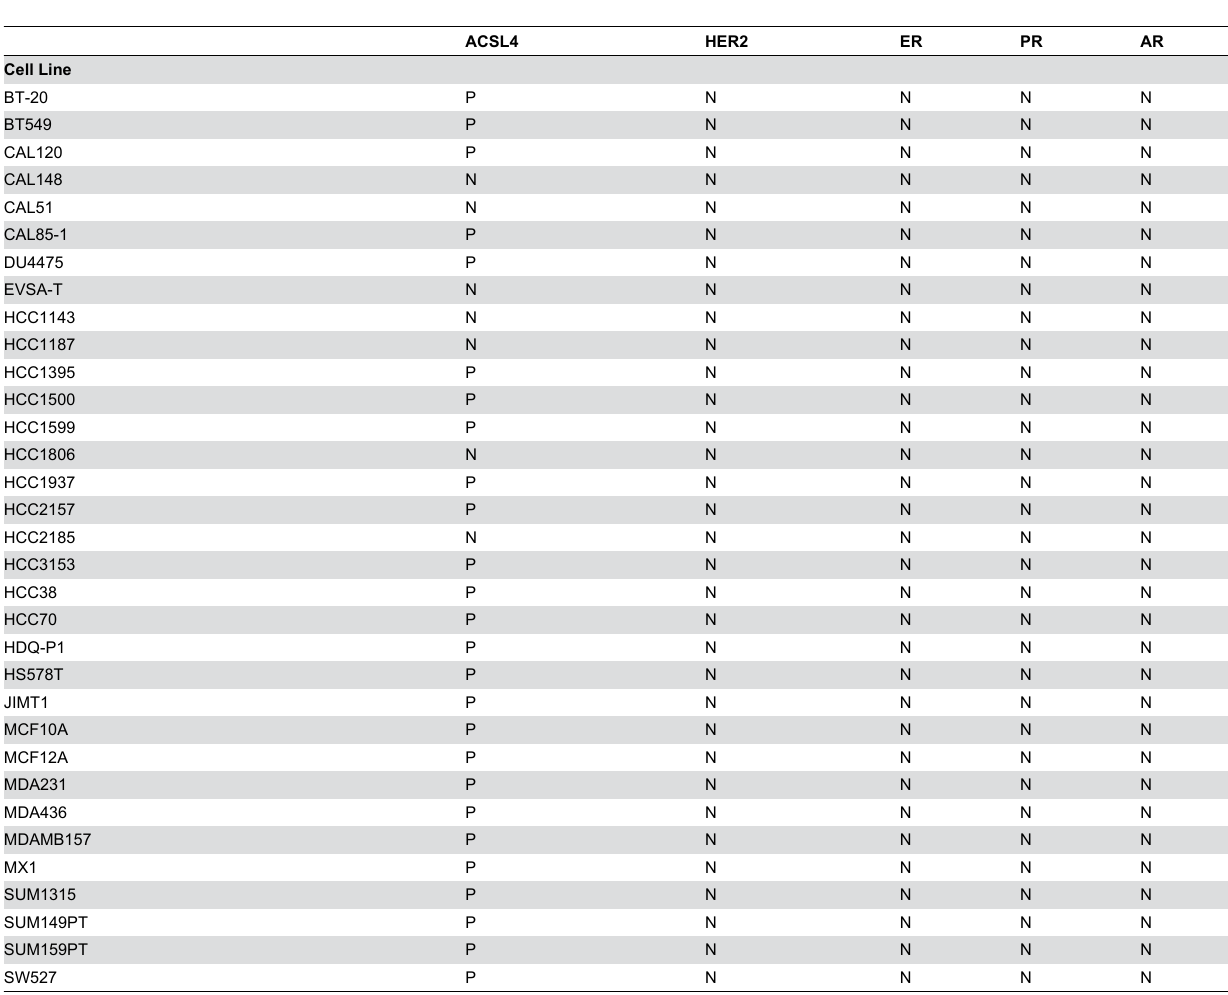
Table 3. ACSL4 expression in steroid hormone/HER2 receptor negative breast cancer cell